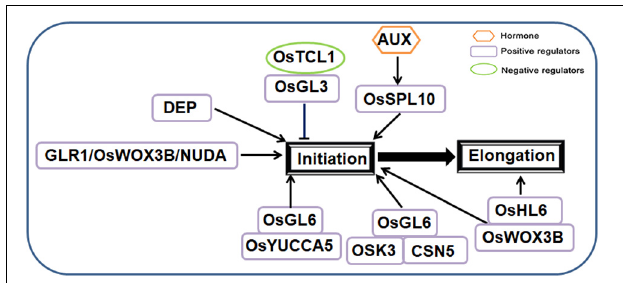
FIGURE 3 | Regulatory network model for trichome development in